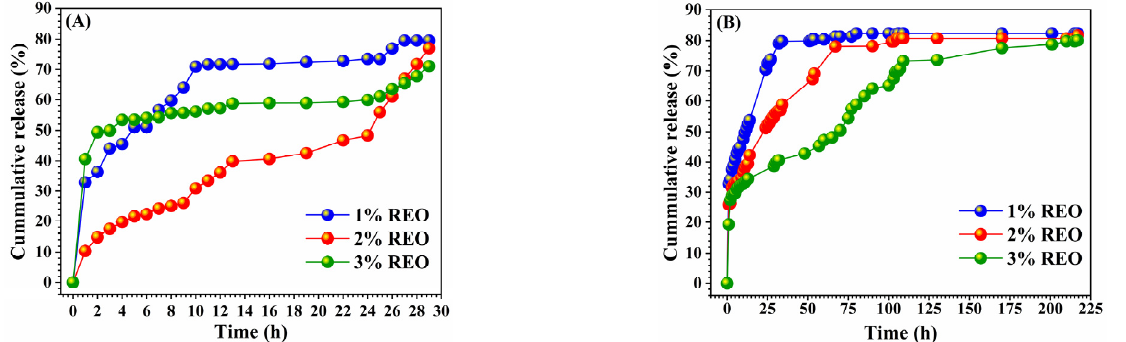
Table 5. Release kinetic parameters (n and k) for the CA and hybrid CA-MTN microcapsules; n is the release exponent related to the drug release mechanisms, k is the rate constant and R 2 is the coefficient of correlation. Kinetic Parameters